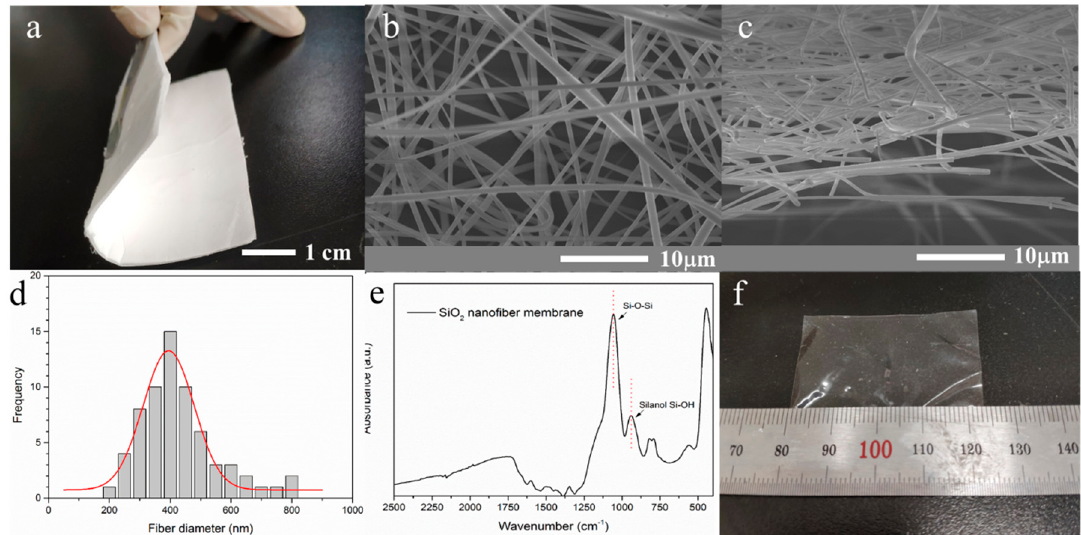
Figure 1. ( a ) Photograph of a pristine silica-nanofiber membrane; ( b ) surface SEM image of the pristine silica-nanofiber membrane; ( c ) cross-sectional surface SEM image of the pristine silica-nanofiber membrane; ( d ) fiber diameter distribution of the pristine silica-nanofiber membrane; ( e ) FT-IR spectrum of the pristine silica-nanofiber membrane; ( f ) photograph of the SiNF-Nafion-3% composite membrane.